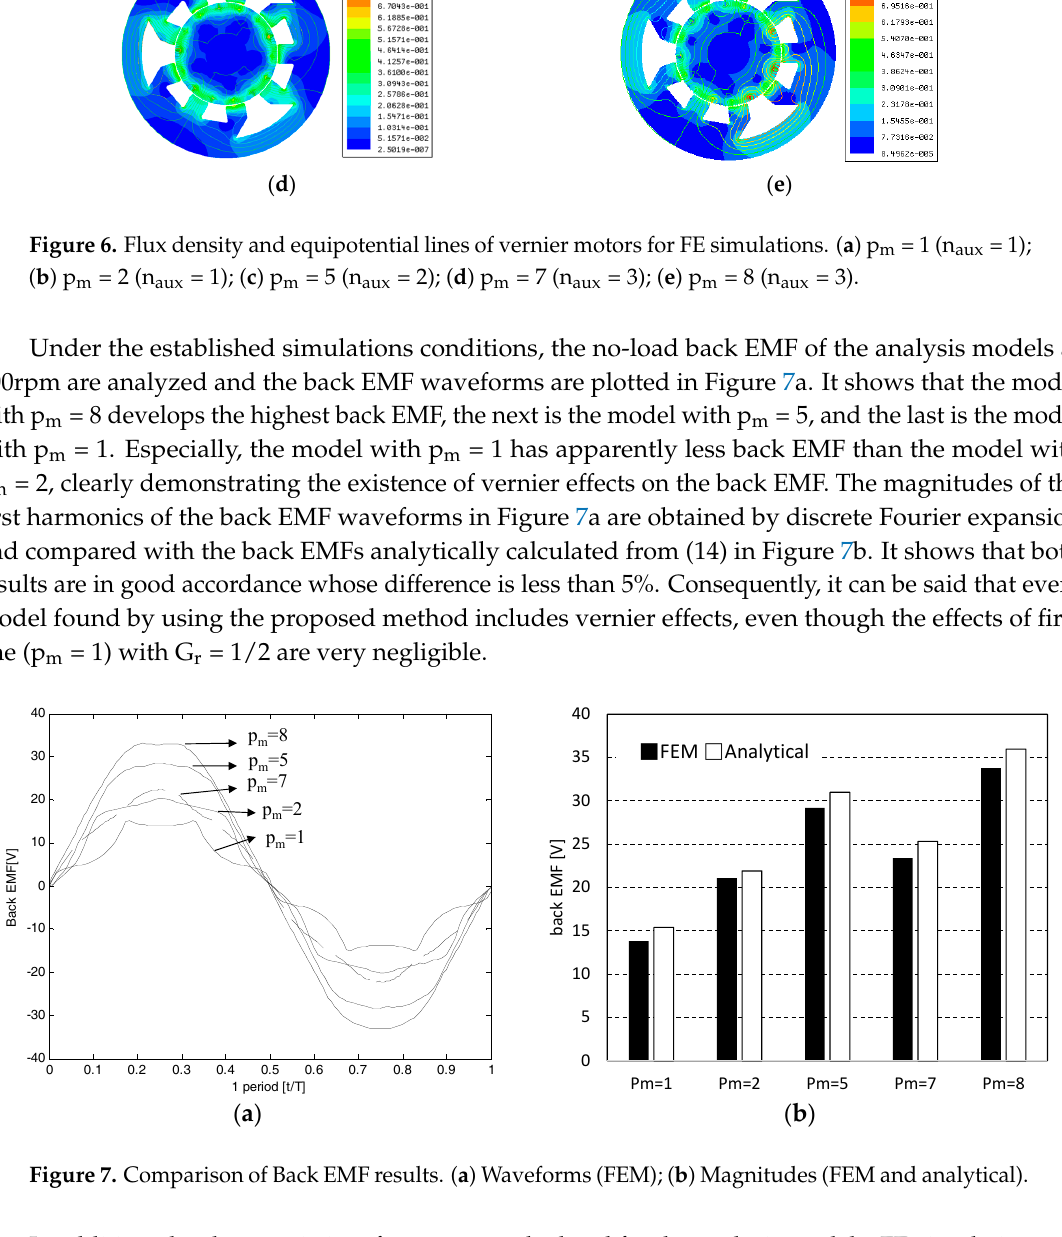
Figure 6. Flux density and equipotential lines of vernier motors for FE simulations. ( a ) p m = 1 (n aux = 1); ( b ) p m = 2 (n aux = 1); ( c ) p m = 5 (n aux = 2); ( d ) p m = 7 (n aux = 3); ( e ) p m = 8 (n aux = 3).